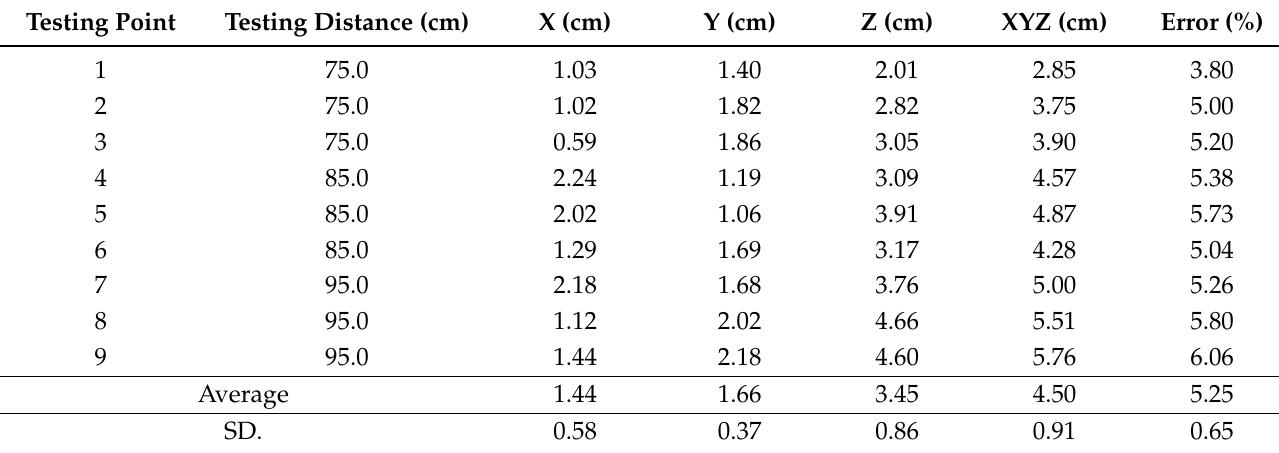
Table 4. Euclidean distance error of the proposed method in 3D spaces.